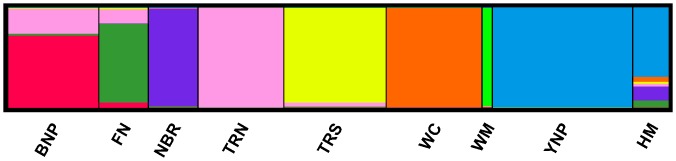
Histogram of Genomic Contributions.A histogram showing the relative contributions of each of the 8 federal bison herds to the Henry Mountains herd for 40 microsatellite loci, in which 129 animals were sampled with K = 8. It also shows contributions of the 8 federal herds to each other’s genetic composition. Herds were identified a priori for analysis. See Fig 2 for herd name abbreviations.